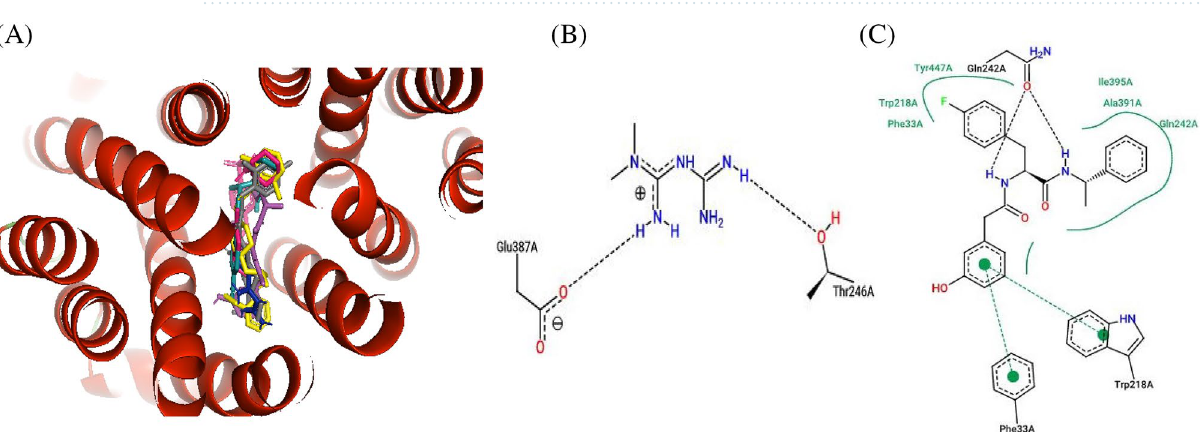
Figure 10. Ligand overlay for haplotype 5 SLC22A2 protein. ( A ) Image was generated using Pymol with the first line anti-diabetic drug, Metformin, shown in blue. The four top binding ligands Dolutegravir, Glibenclamide, Isavuconazole and Ranolazine are shown in grey, hot-pink, deep teal, and yellow respectively. The 5RE inhibitor is indicated in magenta. ( B,C ) 2D PoseView illustration, showing interacting residues for Metformin and the 5RE inhibitor respectively—dotted black lines denote hydrogen bonds, solid green lines denote hydrophobic interactions and dotted green lines denote π stacking &/or aromatic